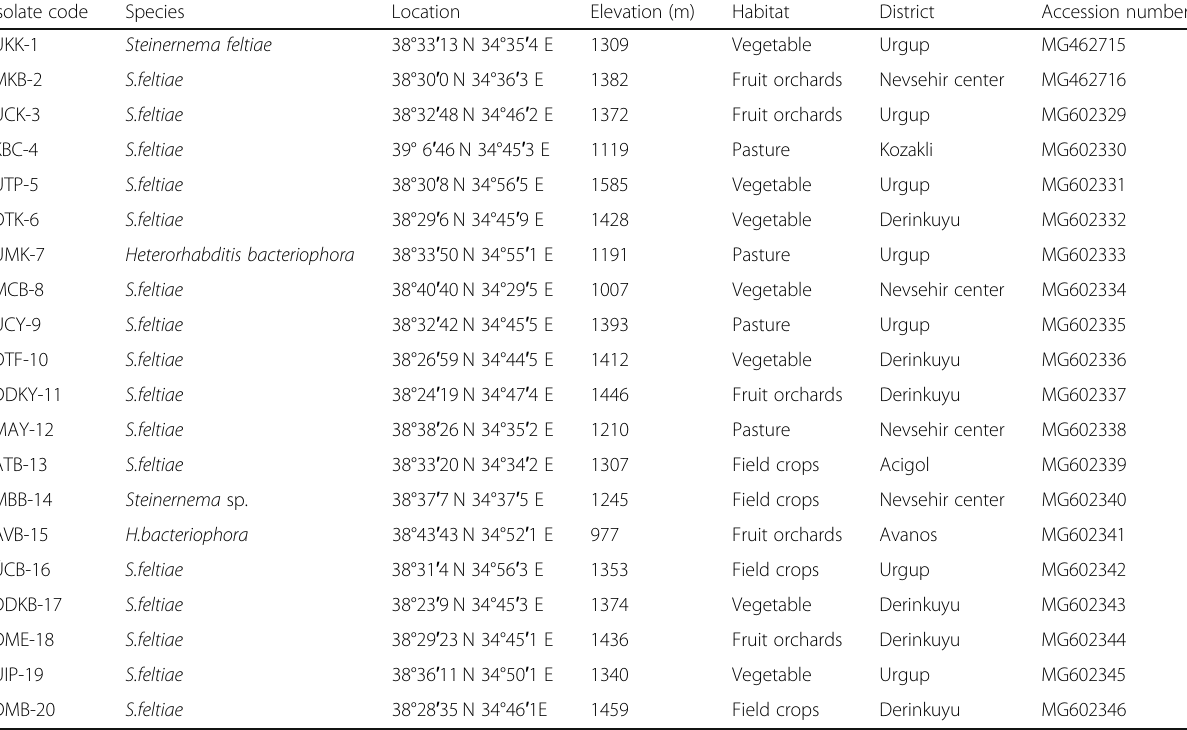
Table 2 Entomopathogenic nematode isolates with habitat characteristics of positive sampling sites and ITS sequence information Isolate